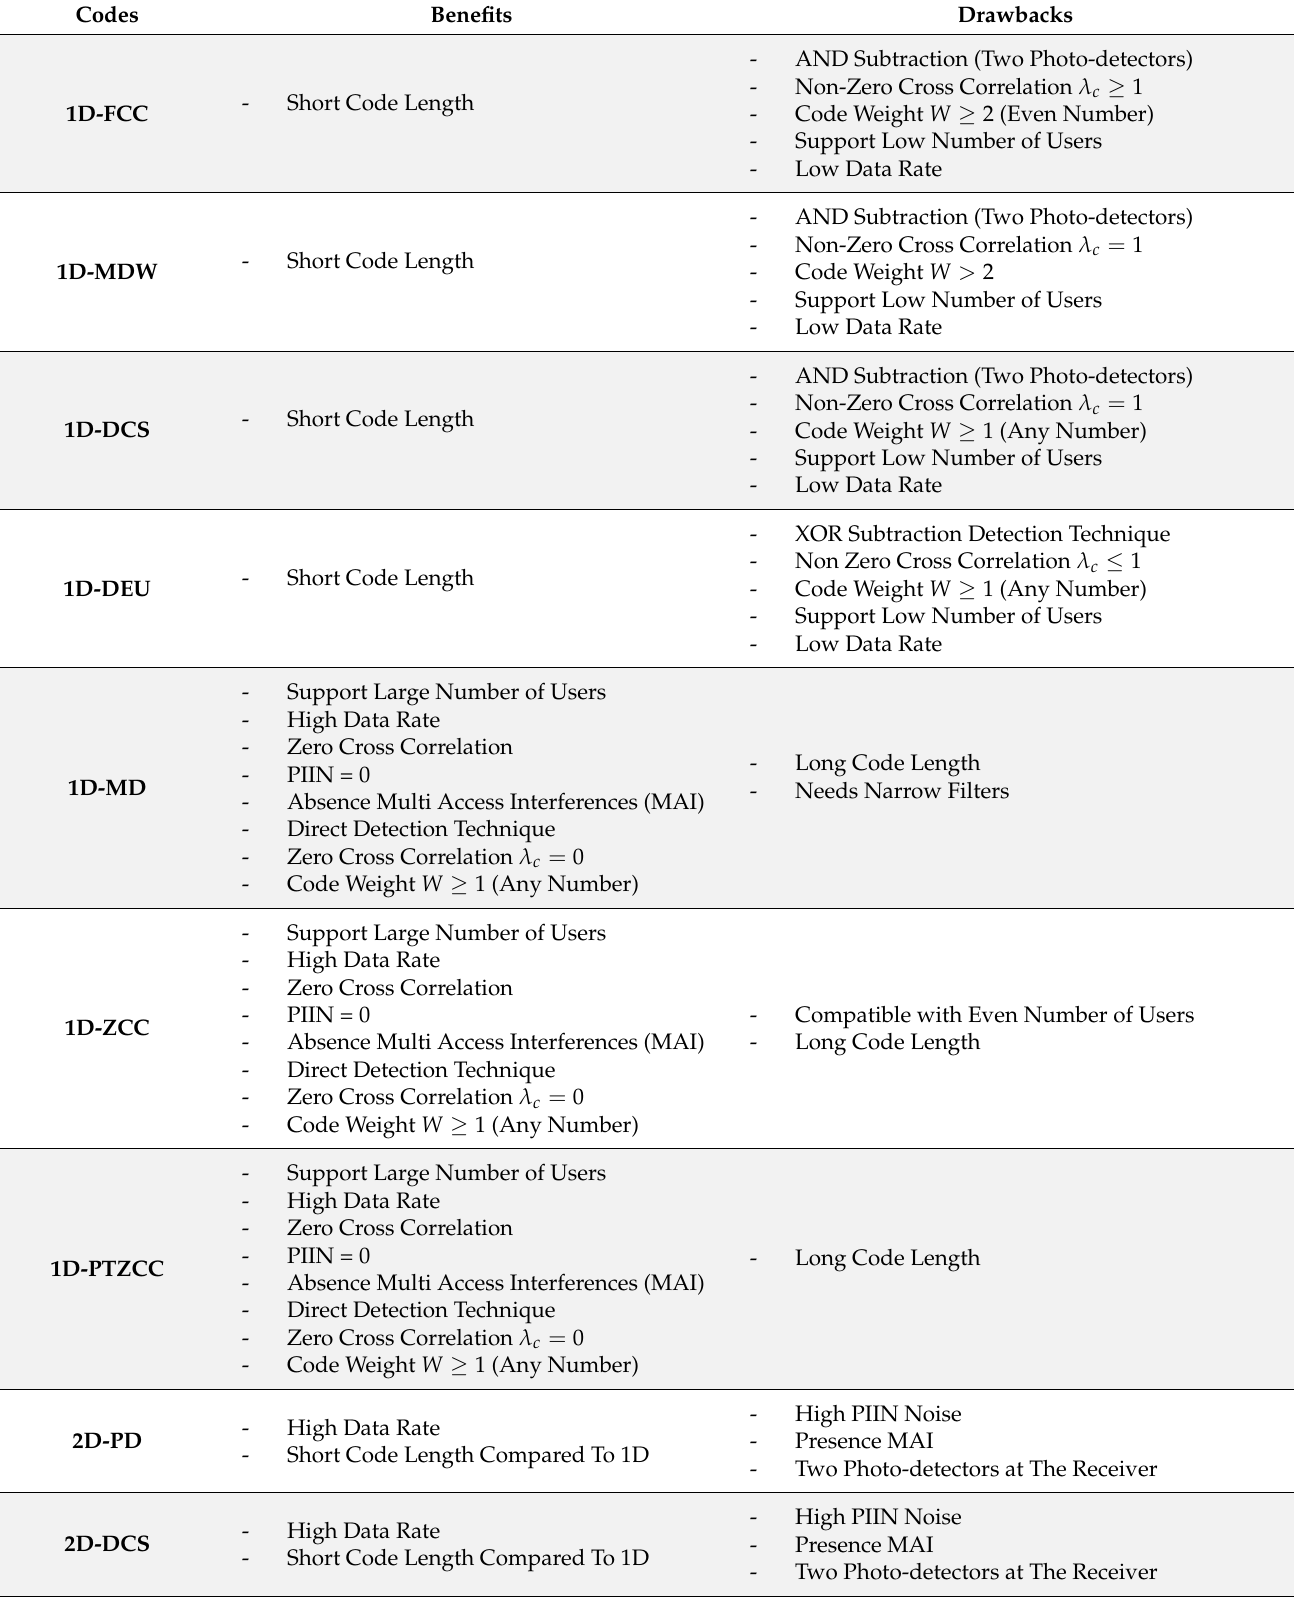
Table 1. Literature review of the various